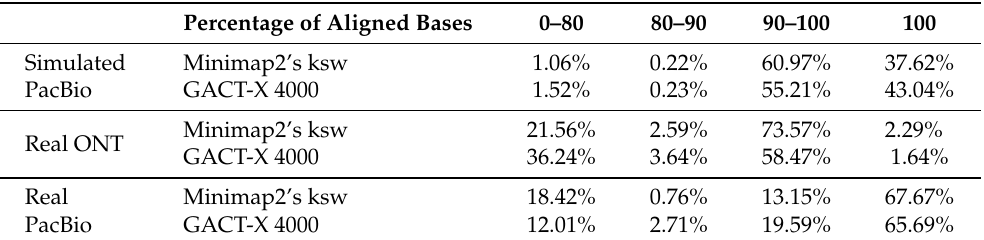
Minimap2’s ksw and GACT-X’s aligned bases percentage of query sequences for three datasets.